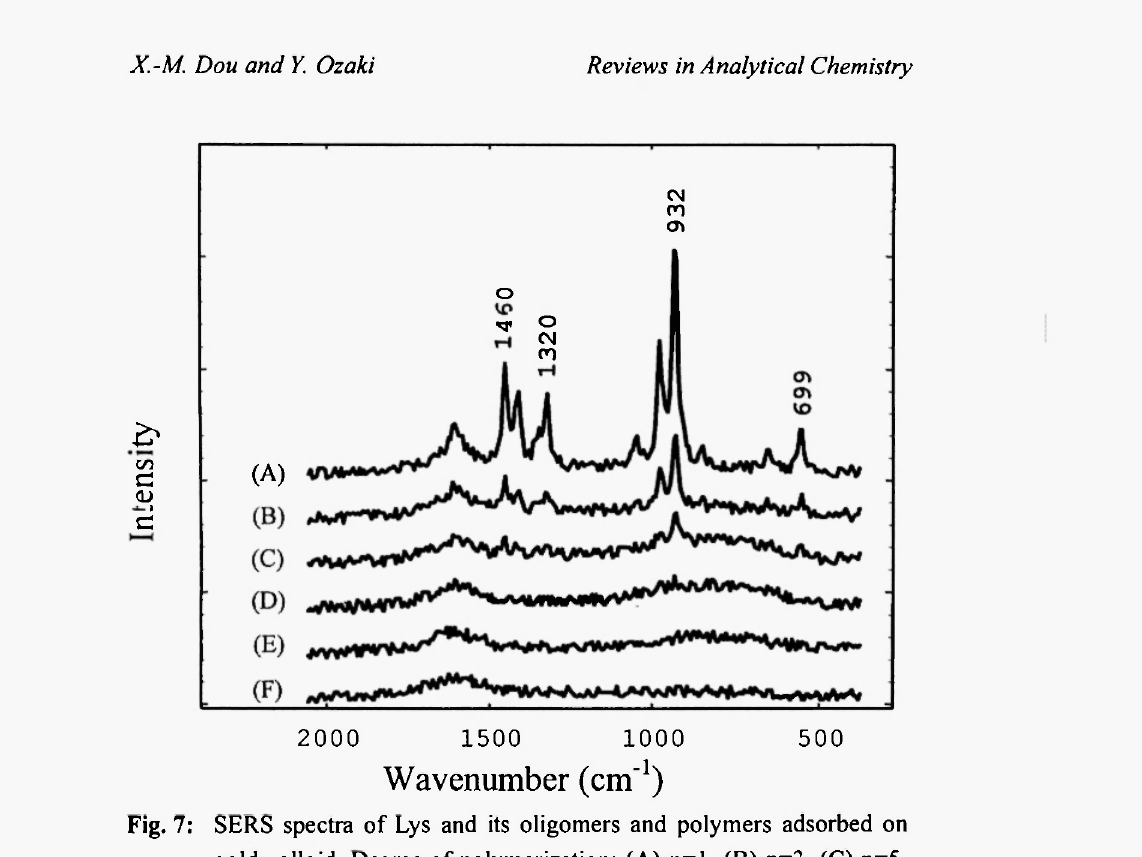
Fig. 7: SERS spectra of Lys and its oligomers and polymers adsorbed on gold colloid. Degree of polymerization; (A) n=l, (B) n=3, (C) n=5, (D) n=17, (E) n=65, (F) n=154. (Reproduced from ref. 20